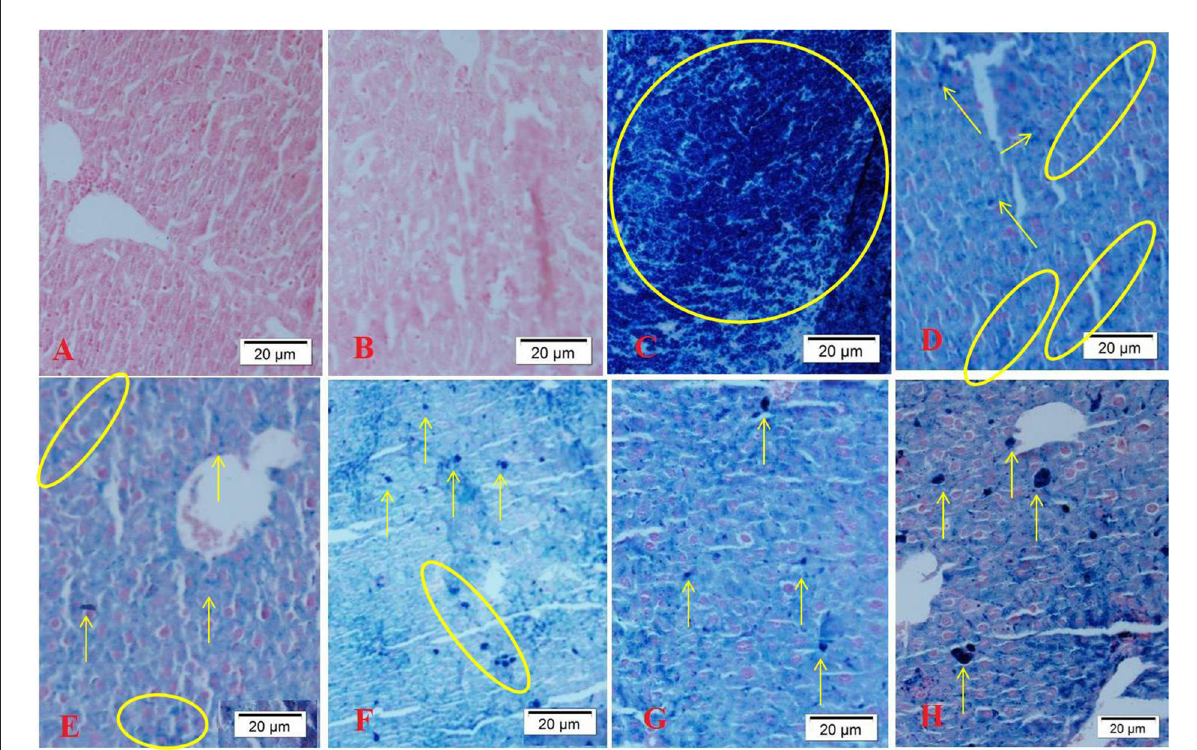
FIGURE5 Perls staining of mice liver tissues (blue spots indicate iron deposition, indicated by arrows and circles; (magnification × 40). (A) Control group, normal saline-receiving group; (B) normal saline and DFO-receiving group; (C) iron dextran and normal saline-receiving group; (D) iron dextran and DFO-receiving group; (E) low dose caffeic acid-receiving group (30 mg/kg/day); (F) high dose caffeic acid-receiving group (50 mg/kg/day); (G) low dose ferulic acid-receiving group (30 mg/kg/day); and (H) high dose ferulic acid-receiving group (50